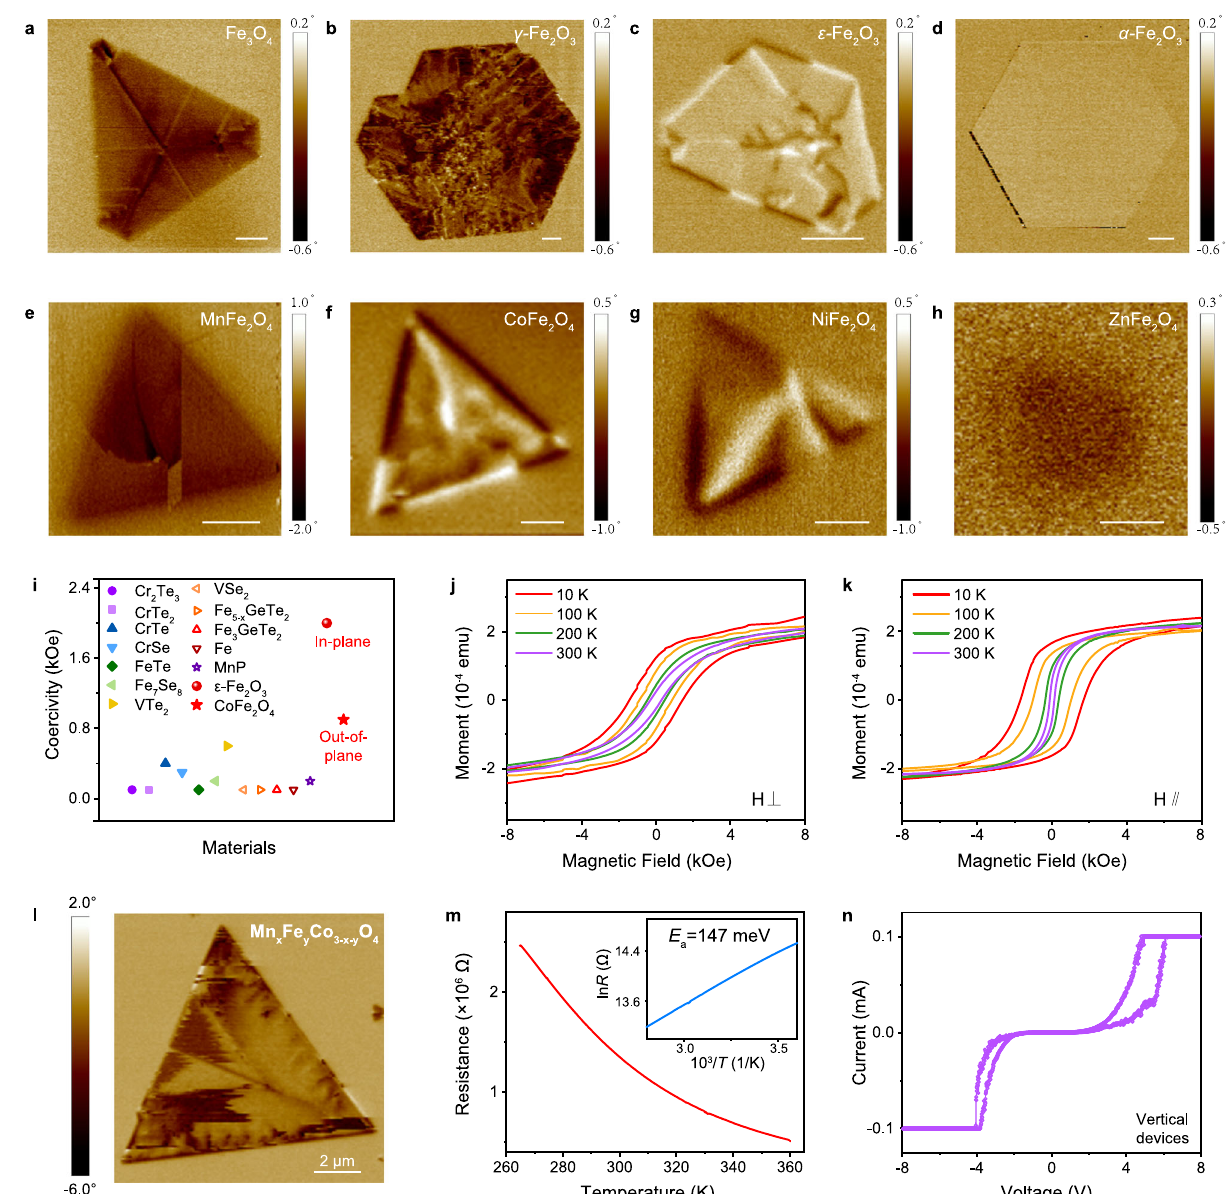
Fig. 5 | Room-temperature magnetism and electrical properties of oxides. a – h Magnetic force microscope (MFM) phase images of Fe 3 O 4 (7.8nm), γ -Fe 2 O 3 (7.3nm), ε -Fe 2 O 3 (10nm), α -Fe 2 O 3 (27nm), MnFe 2 O 4 (20nm), CoFe 2 O 4 (18nm), NiFe 2 O 4 (15nm), ZnFe 2 O 4 (29nm), respectively. Scale bars: a – d , 2 μ m; e – h , 1 μ m. i Comparisonofcoercivityat200Kin ε -Fe 2 O 3 andCoFe 2 O 4 withother2Dmagnets. j Magnetic hysteresis of Mn x Fe y Co 3-x-y O 4 alloy with magnetic fi eld